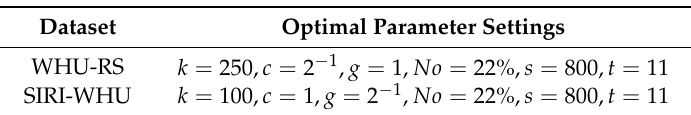
Table 1. The optimal parameter settings for two target